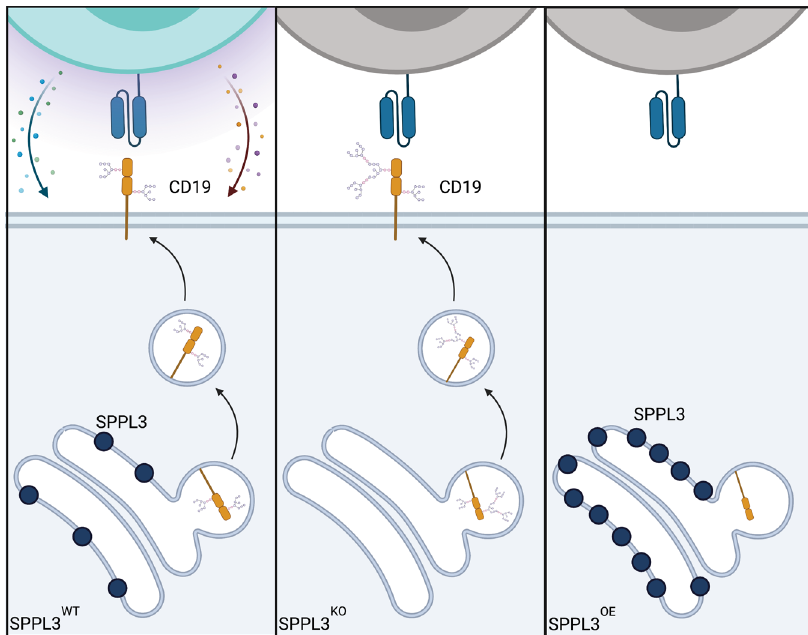
Fig. 6 Proposed model for the mechanism of glycosylation-mediated antigen escape. (left) Normal SPPL3 function results in standard glycosylation of CD19. (Middle) Loss of SPPL3 results in increased and altered glycosylation, disrupting the CAR binding epitope. (Right) Increased SPPL3 results initially in decreased glycosylation followed by degradation of CD19, preventing surface